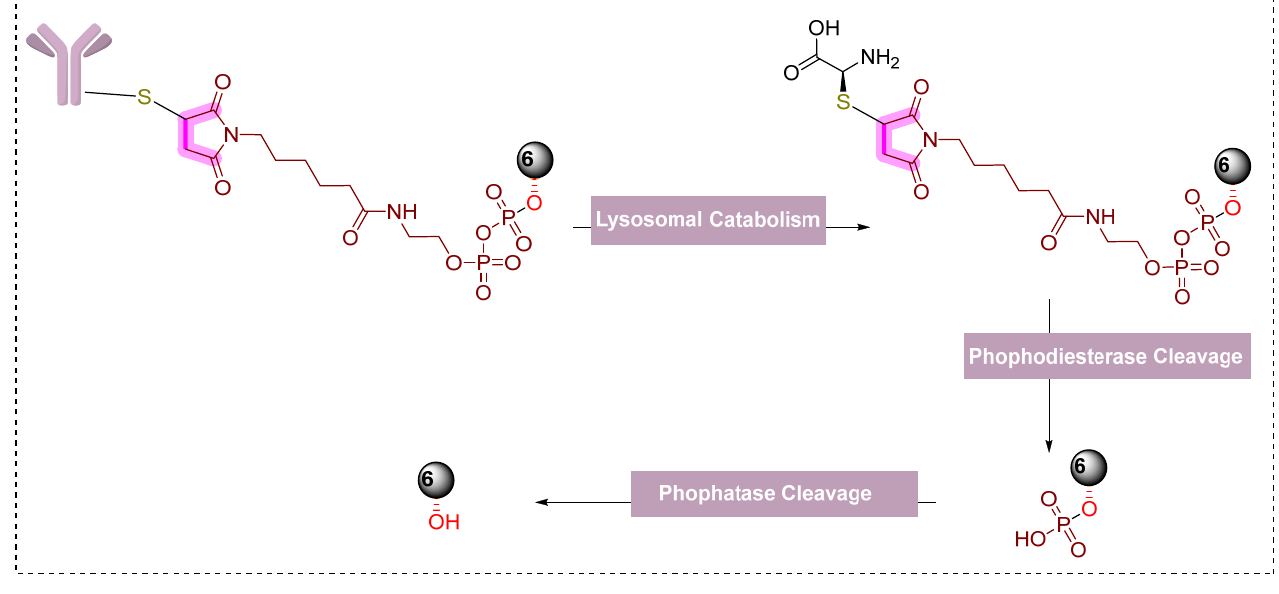
Figure 20. Improved ADC approach for delivery of VHL-PROTAC-6